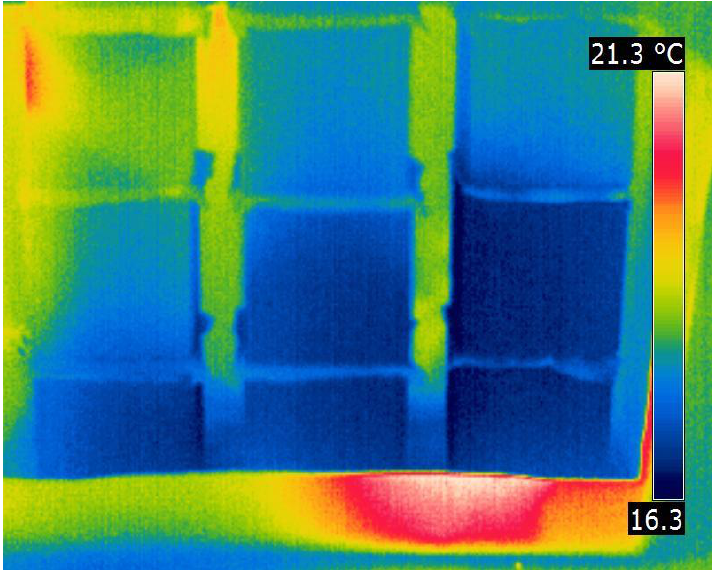
Figure A8. Thermographic report dated December 7, 2018, for Carparo (C.), Lecce stone (L.S.), and Tuff (T.).